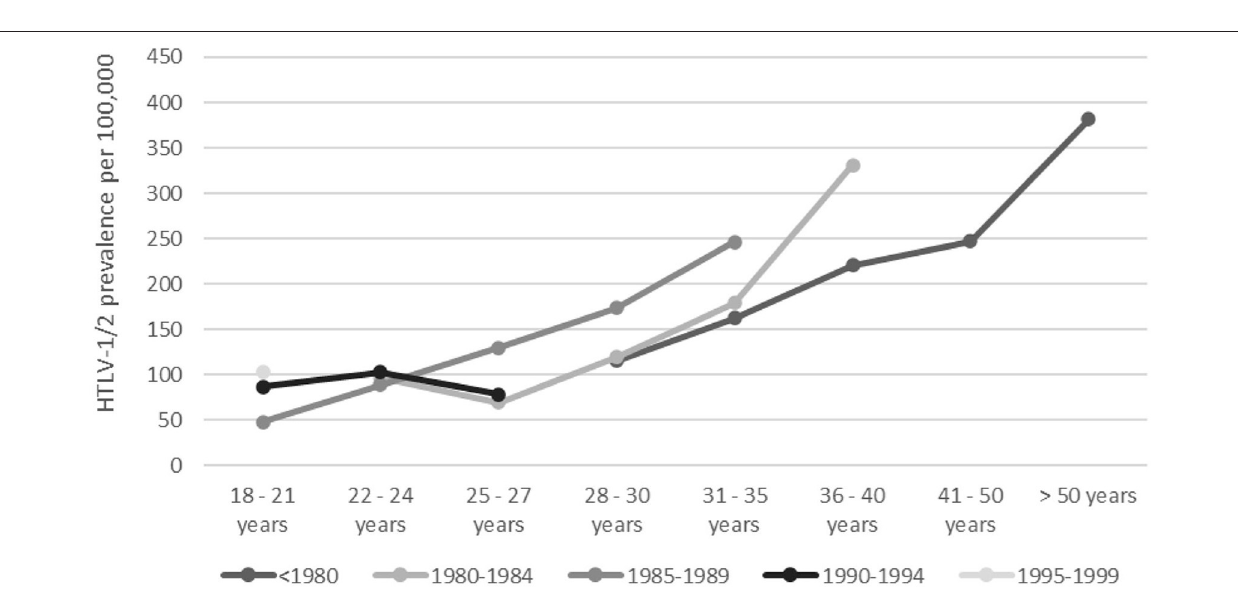
FIGURE 2 | HTLV-1/2 prevalence by age and birth cohort. Dots and lines of differing color indicate birth cohorts as specified under the